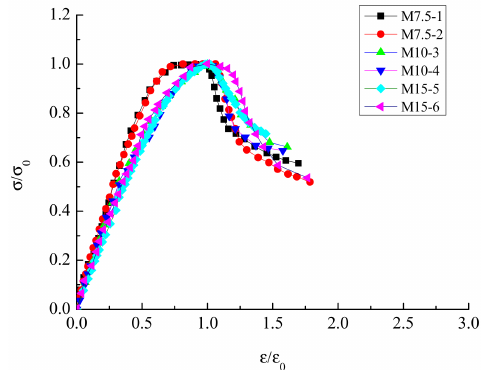
Figure 6. Dimensionless stress–strain curves.